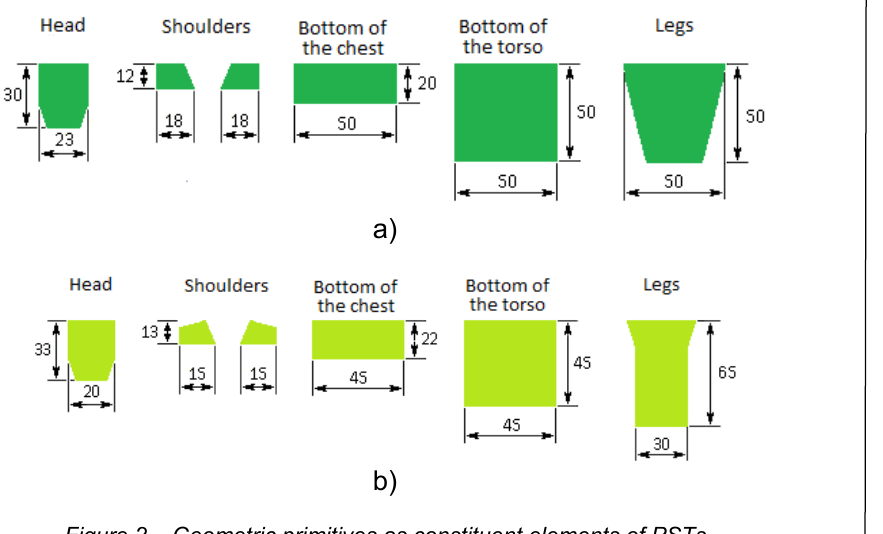
Figure 2 – Geometric primitives as constituent elements of PSTs a) Soviet / Russian targets; b) Swiss